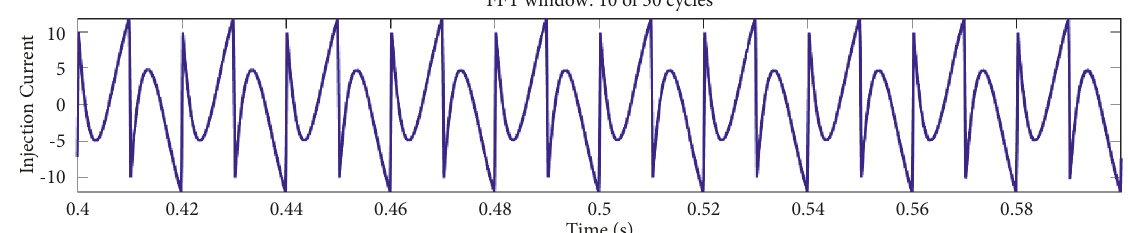
Figure 30: Source current before compensation (a) distorted waveform (b) frequency spectrum with THD 32.63%. FFT window: 10 of 30 cycles